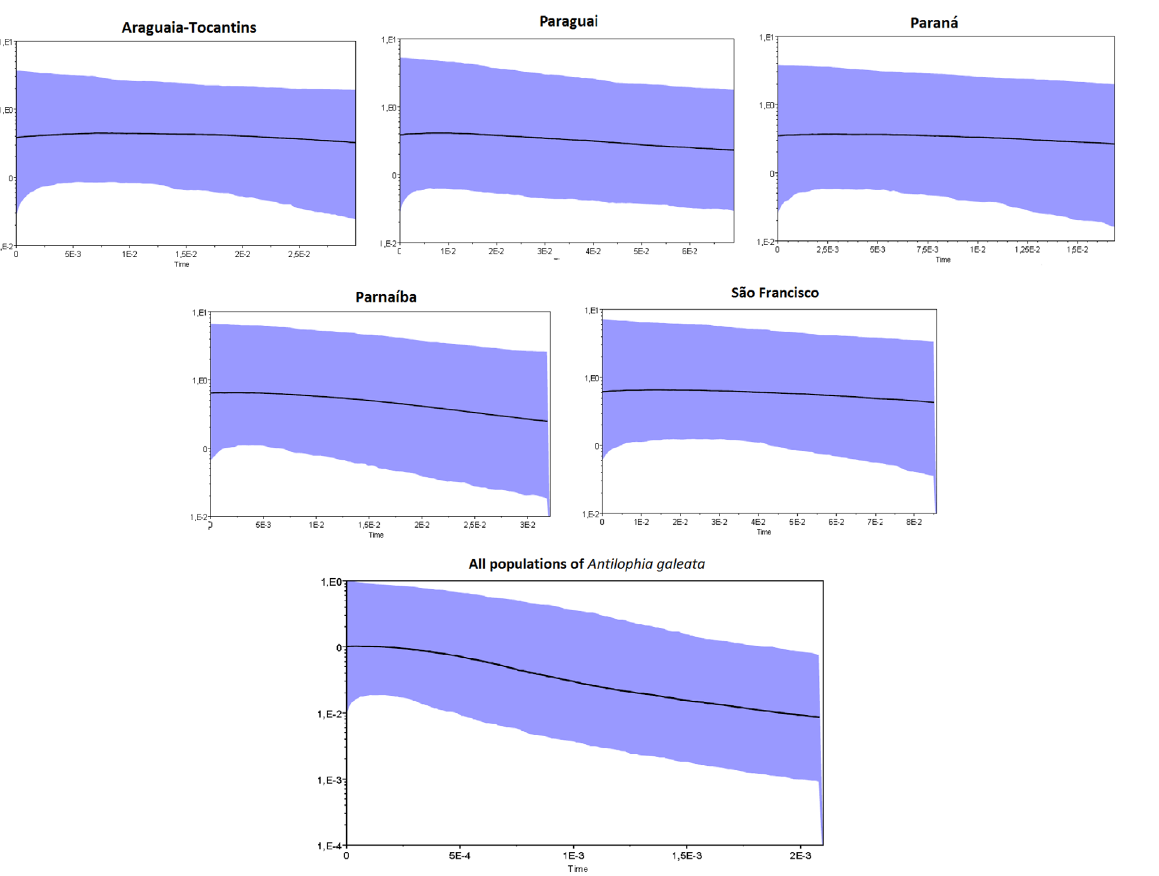
Figure 3. Bayesian Skyline Plot showing the effective size of the Antilophia galeata populations found in the five hydrographic basins of the Cerrado and the complete population, considering all the datasets combined. The solid line represents the variation in the effective size of the population over